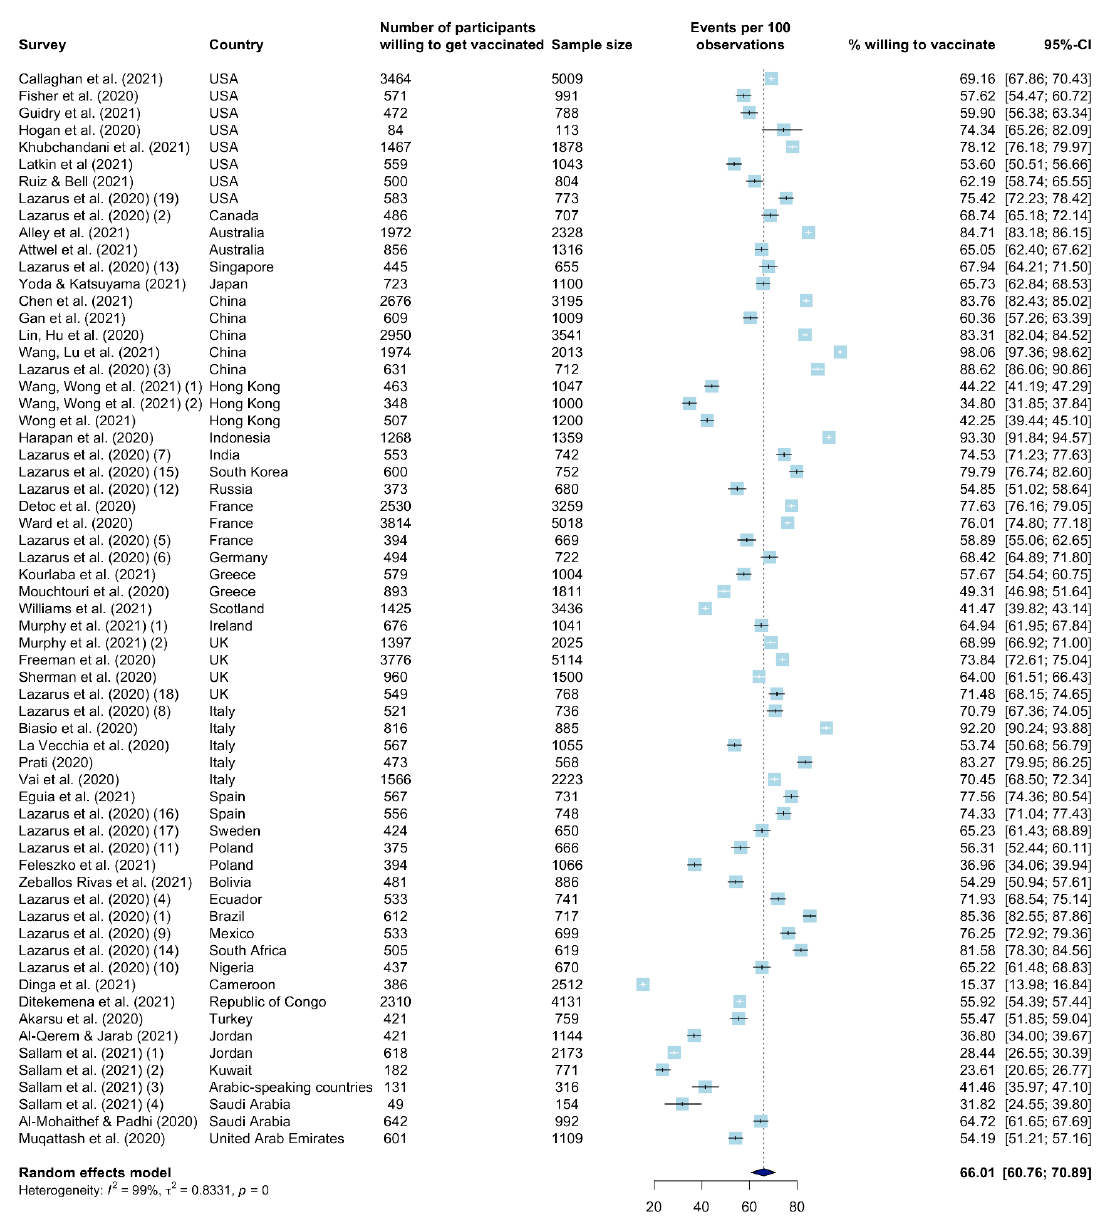
Figure 2. Forest plot of the worldwide vaccination willingness